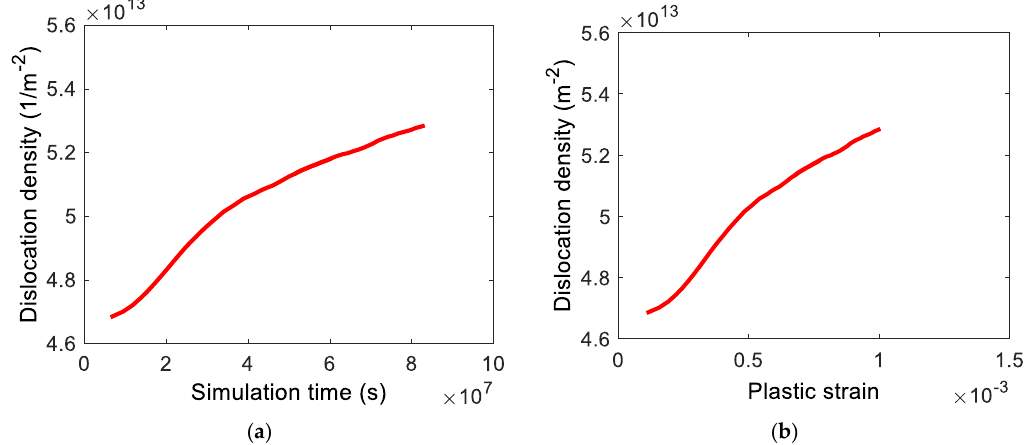
Figure 4. ( a ) Plastic strain and ( b ) plastic strain rate versus simulation time for deformation with the original mobility value M glide = 2.89 × 10 −13 (Pa·s) −1 .